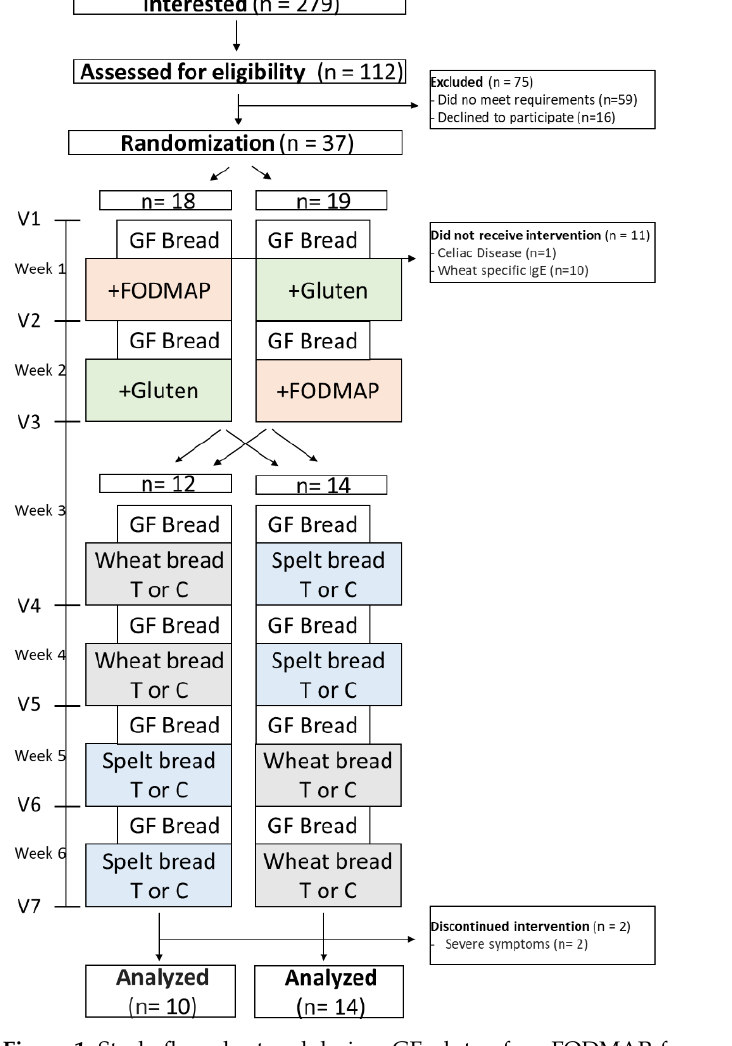
Figure 1. Study flow chart and design. GF, gluten-free; FODMAP, fermentable oligo-, di-, monosac- charides and polyols; T, traditional recipe; C, current recipe; V1–7, study visit 1–7. For further details, see text.